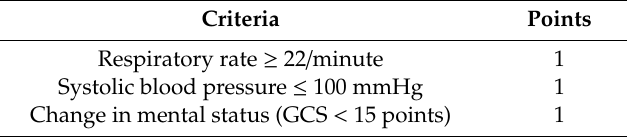
Table 1. Quick sequential organ failure assessment score (qSOFA).